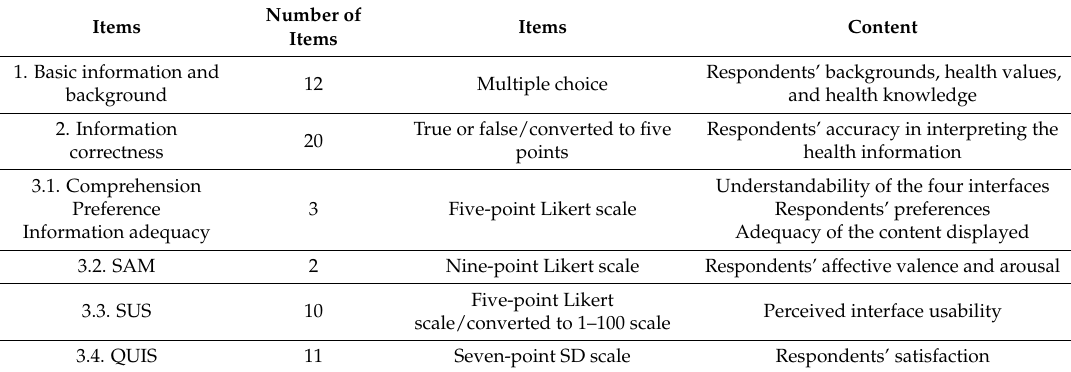
Table 3. Questionnaire